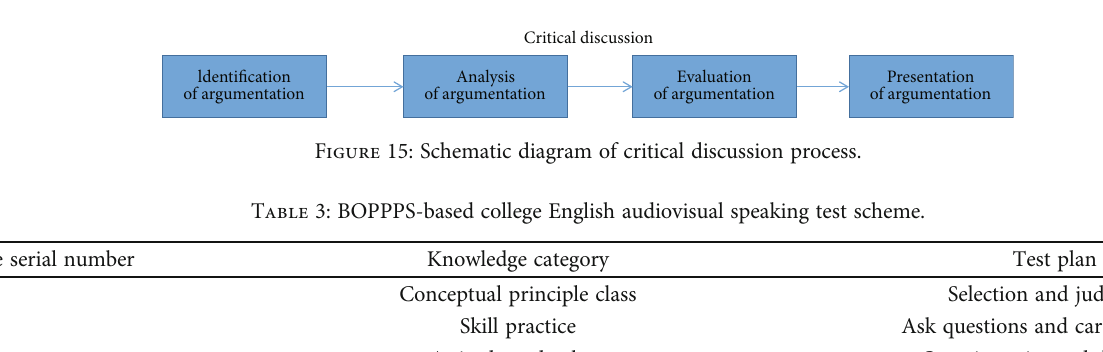
Figure 14: Circular ecology of college English classroom based on BOPPPS model.